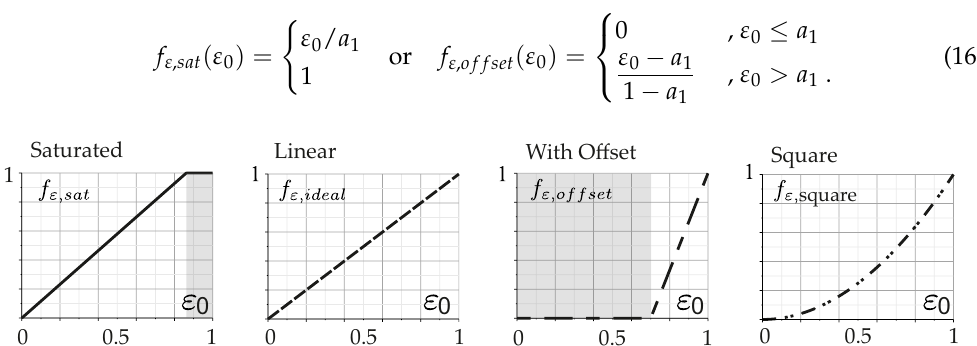
Figure 7. Self-map function: function course of a modified distribution key f ε , mod .